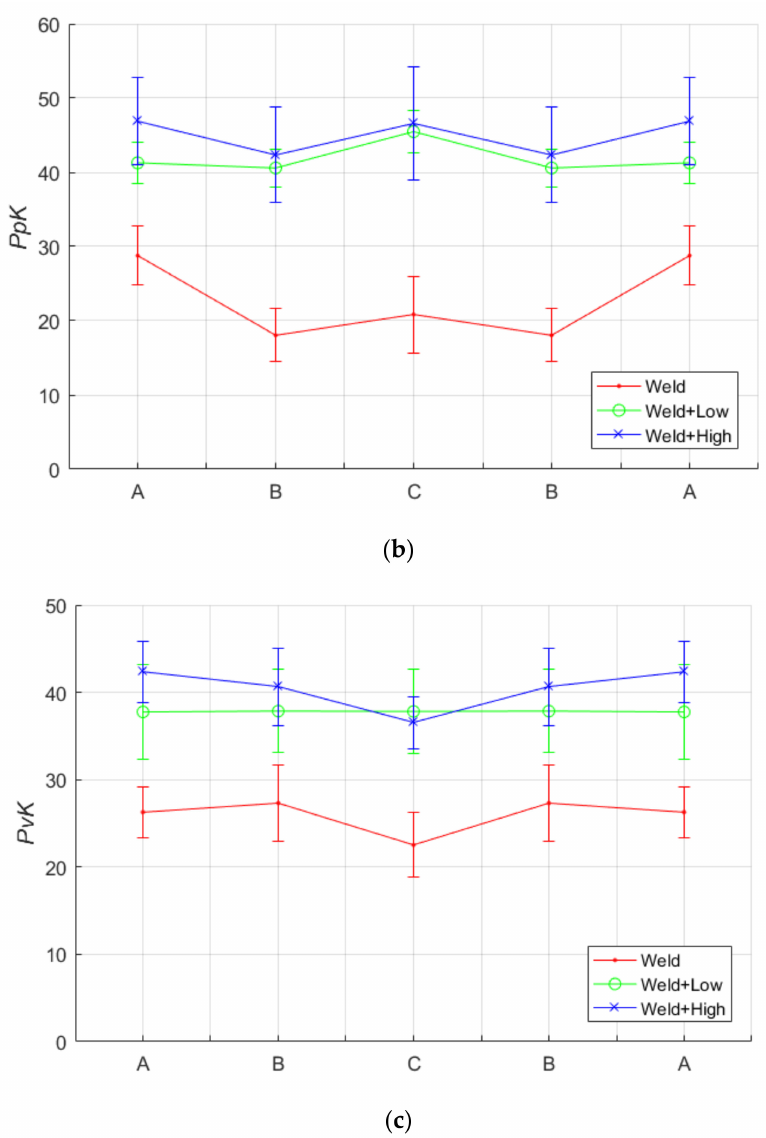
Figure 15. Optical roughness metrics (in %) for three samples in the three ROIs shown in Figure 11. ( a ) R a ; ( b ) P p K ; ( c ) P v